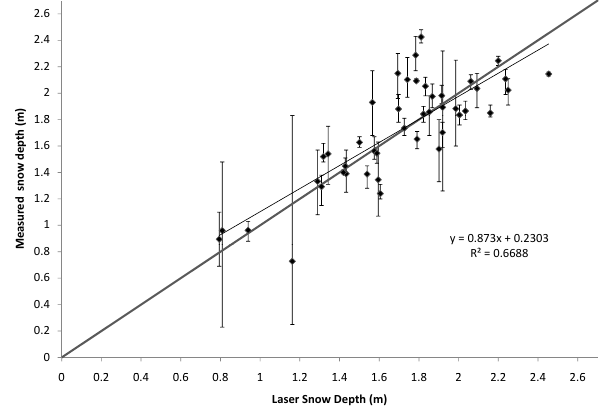
Fig. 4. Manually measured versus calculated snow depths at the validation slope. Error bars represent the range of measured depths at each point.